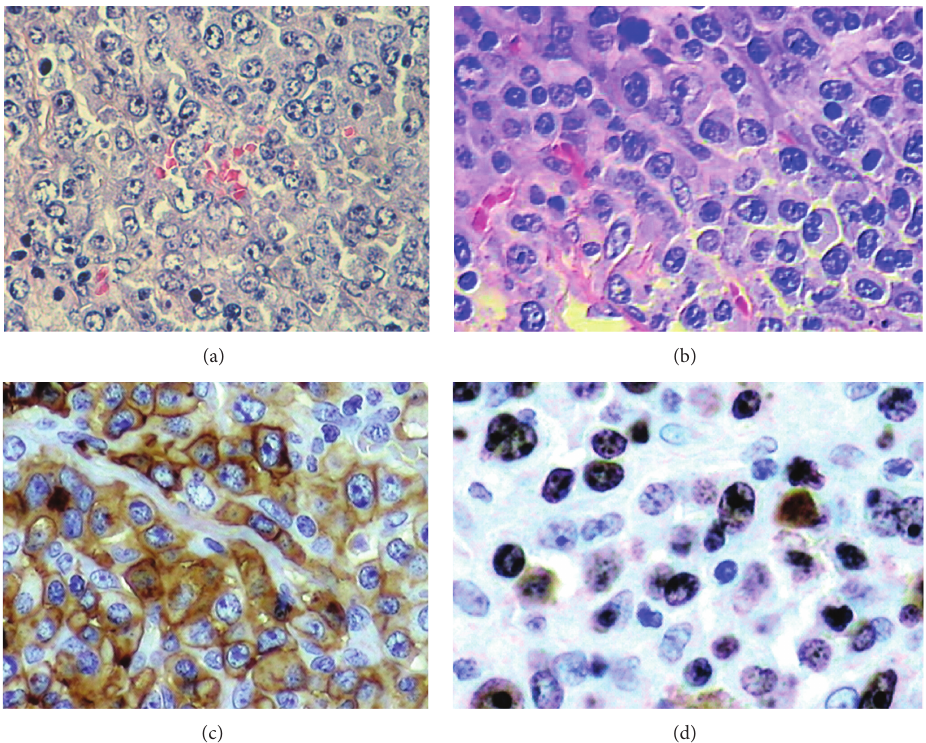
Figure 3: Histologic features: (a) diffuse proliferation of lymphoid tumor cells (hematoxylin-eosin stain (HE), magnification × 200) was observed. (b) Large pleomorphic cells with an abundant cytoplasm, sometimes containing prominent nucleoli, were verified. “Hallmark” cells with eccentric, horse-shoe, or kidney-shaped nuclei were also identified (HE, magnification × 400). Immunohistochemical findings: sections showing tumor cells are positive for (c) CD30 with a membrane and Golgi distribution (streptavidin-biotin, × 400 magnification) and (d) Ki-67 (streptavidin-biotin, × 400